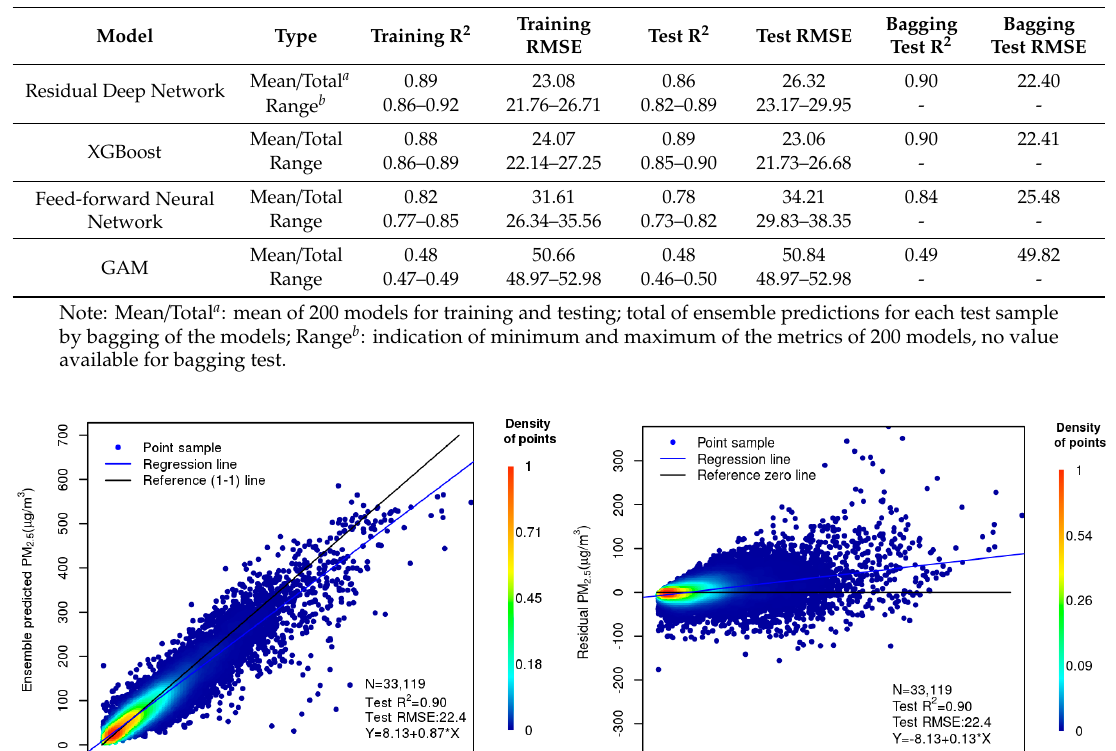
Table 2. Comparison of GAM, feed-forward neural network and residual deep network for PM 2.5 spatiotemporal estimation.